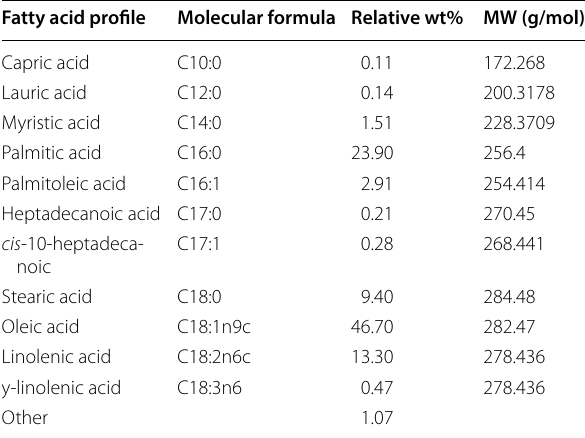
Table 4 Fatty acid composition of waste oil of rendered pork